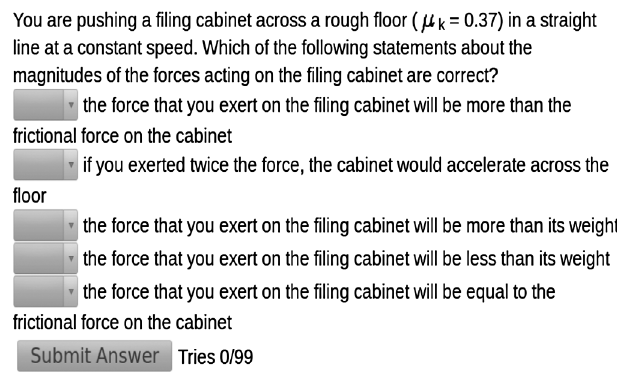
FIG. 1. An example of the type of problem discussed in